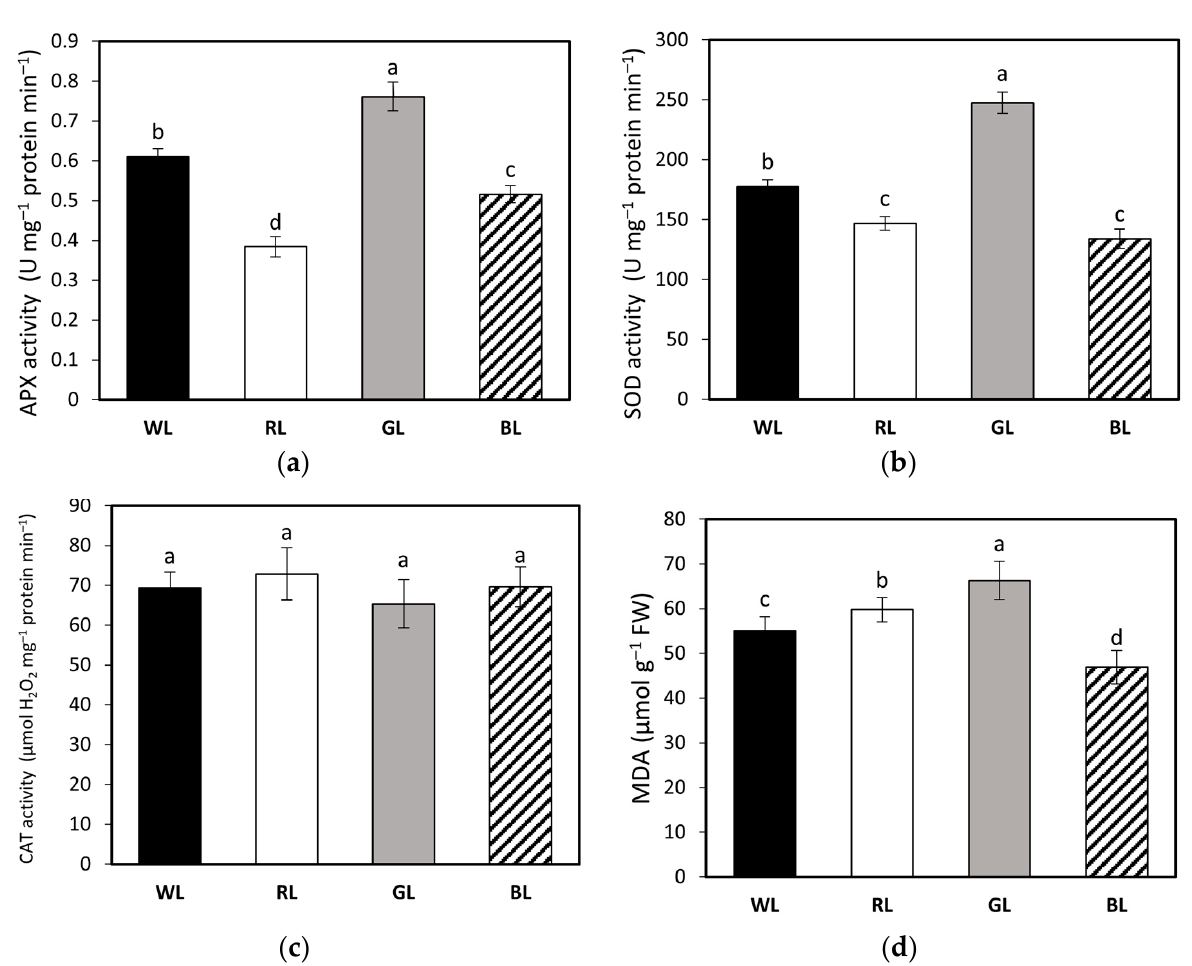
Figure 8. Ascorbate peroxidase (APX, a ), superoxide dismutase (SOD, b ) and catalase (CAT, c ) enzyme activity levels, and malondialdehyde (MDA, d ) accumulation in leaves of tomato plants ( Solanum lycopersicum L. cv. Malinowy Ozarowski) grown under different light conditions (see Material and Methods for details). Bars show the means ± SD ( n = 4). Different letters indicate significant differences between treatments ( p = 0.05) with a Tukey’s HSD test. U—unit of enzyme activity. FW—fresh weight.